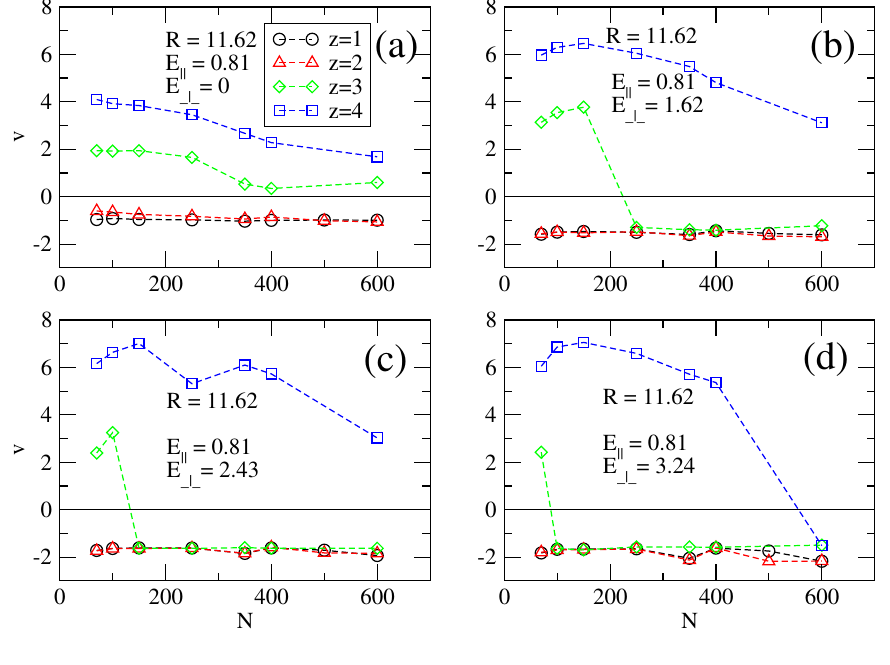
Figure 3. Electrophoretic velocities v = v ( N ) for cylinder of radius R = 11 . 62 for ( a – d ) transversal fields of E = 0 , 1 . 62 , 2 . 43 and 3 . 24 , respectively. The longitudinal field ⊥ is constant, E = 0 . 81 k